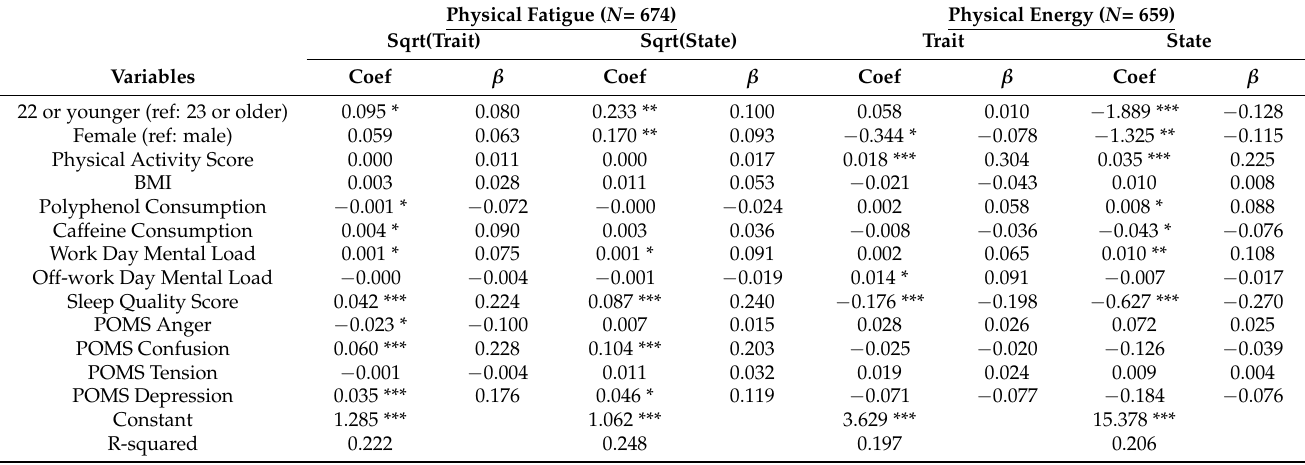
Table 3. Comparing predictors of trait and state physical energy and